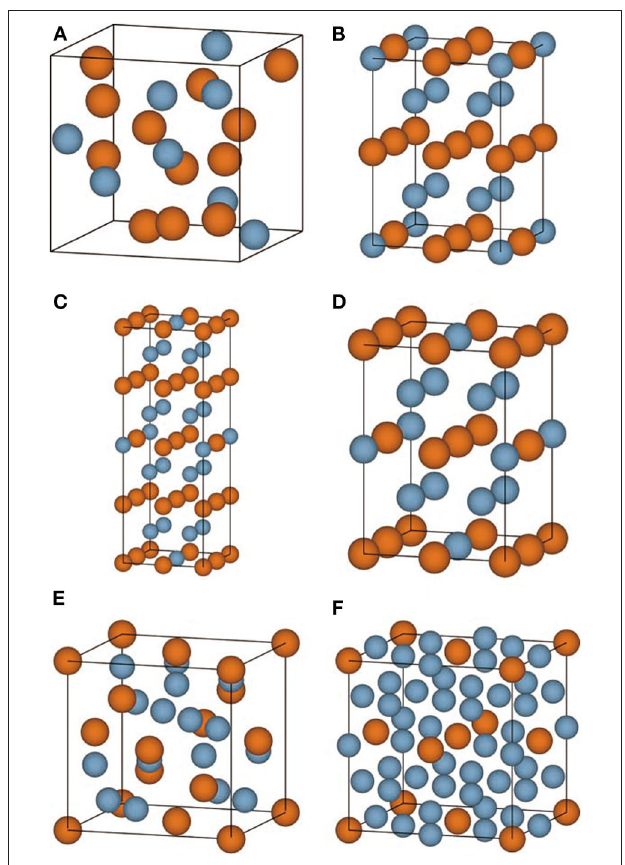
FIGURE 3 | (A–F) The side view of conventional crystal structures of Mg 12 Al 8 , Mg